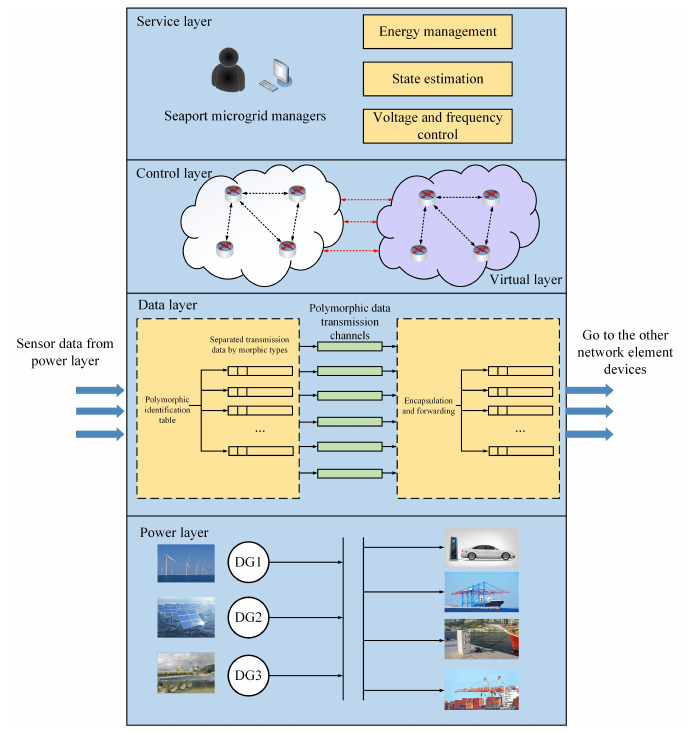
Figure 2. Illustrated framework of polymorphic seaport